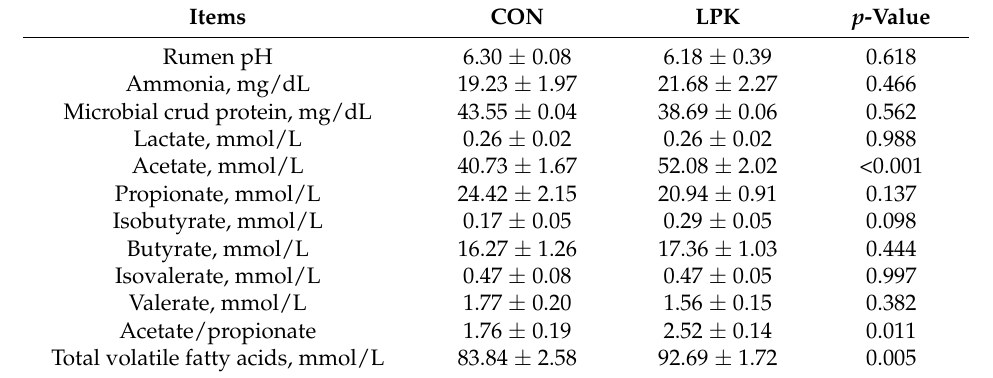
Table 4. Effects of live Pichia kudriavzevii on rumen fermentation parameters of Hu sheep 1 .